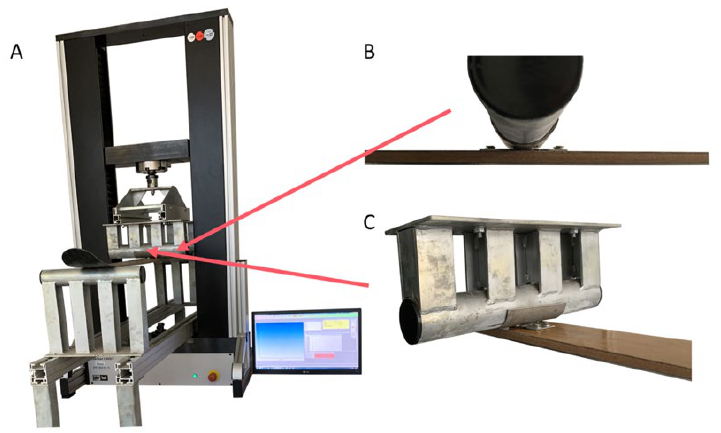
Figure 3. Modification of the Labortech test machine with the developed jig for testing in bending: ( A ): Test rig with special jig and ski placement, ( B , C ): Detailed view of jig and ski attachment.